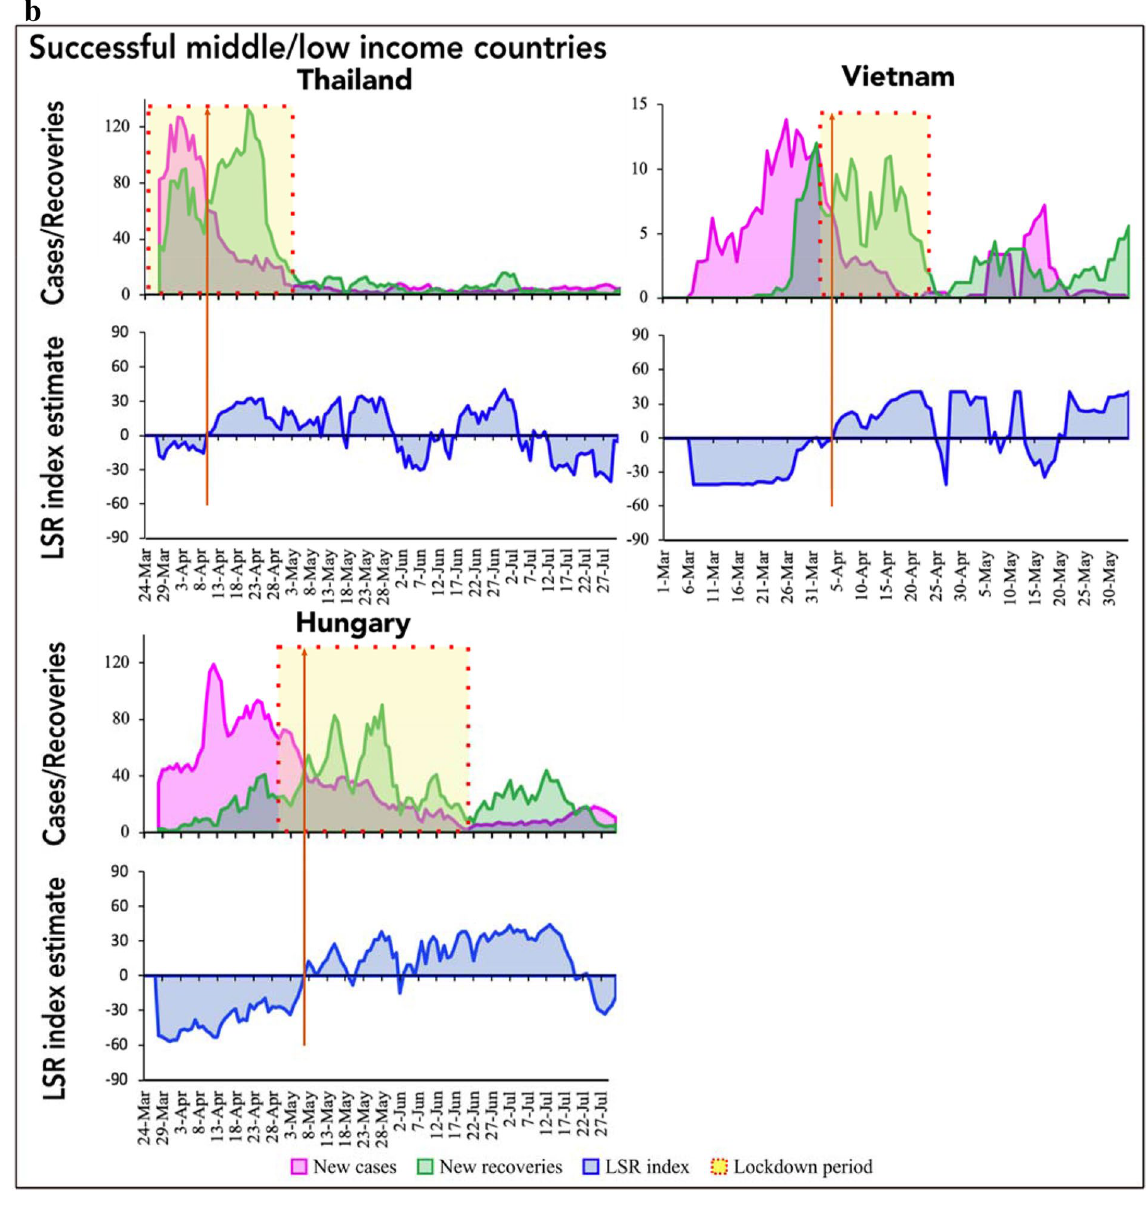
Illustration of the application of LSR index based on SIRM simulation. Figure 4 illustrates the likely impact of premature and timely reopening in Germany and Iran, respectively, as examples to illustrate successful and unsuccessful scenarios. The results from the SIRM modelling demonstrate that if Germany had a hypothetical early reopening—e.g., on the day of I-R crossover—this would have triggered a significantly higher immediate resurgence. To quantify this difference: there would have been 3,828 additional daily new cases dur- ing the simulated “after peak” if reopening happened at the crossover date, compared to the case counts during the peak following the actual reopening date (Fig. 4, top panel). In contrast, the actual reopening by Iran (i.e., 3 days following the I-R crossover) led to a significant resur- gence (shown by the orange bars for “observed events”; Fig. 4, bottom panel). However, if Iran reopened 20 days after I-R crossover (i.e., in accordance to calculated LSR index for Iran), a significantly lower second peak would have resulted. To quantify, the simulated after peak for the actual reopening would have resulted in 3,534 daily cases, whereas following the LSR-based reopening, there would be only 1,401 daily cases during a simulated after peak (Fig. 4, bottom panel). These results indicate that the LSR-based reopening approach for Iran would have prevented a higher resurgence of the